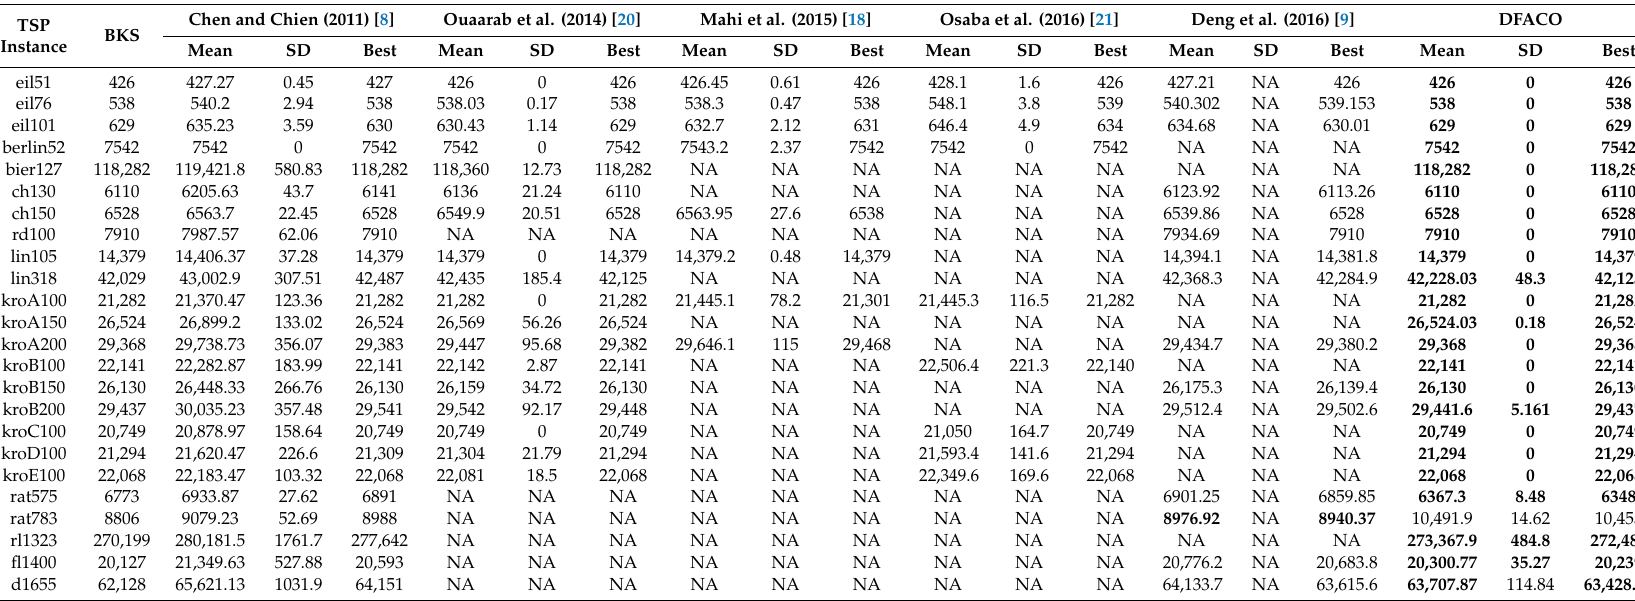
Table 5. Experimental results of proposed method compared with recent research (NA indicates that results were not reported in the original